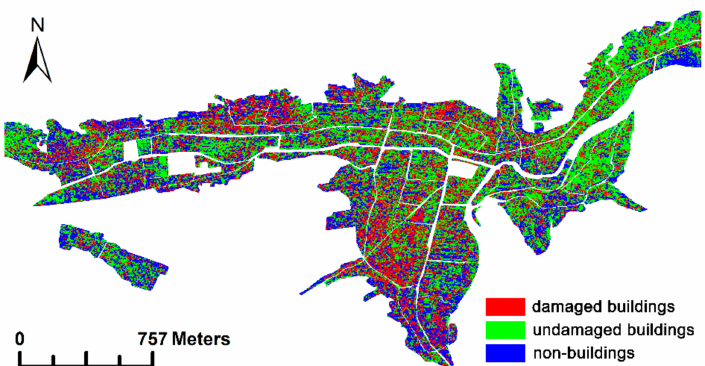
Figure 9. Extraction results for the damaged buildings, undamaged buildings, and non-buildings in the earthquake-stricken area of Yushu County for all of the city blocks.